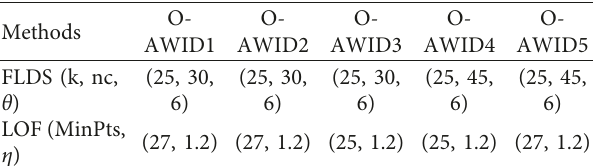
Table 4: The parameters used in data sets.